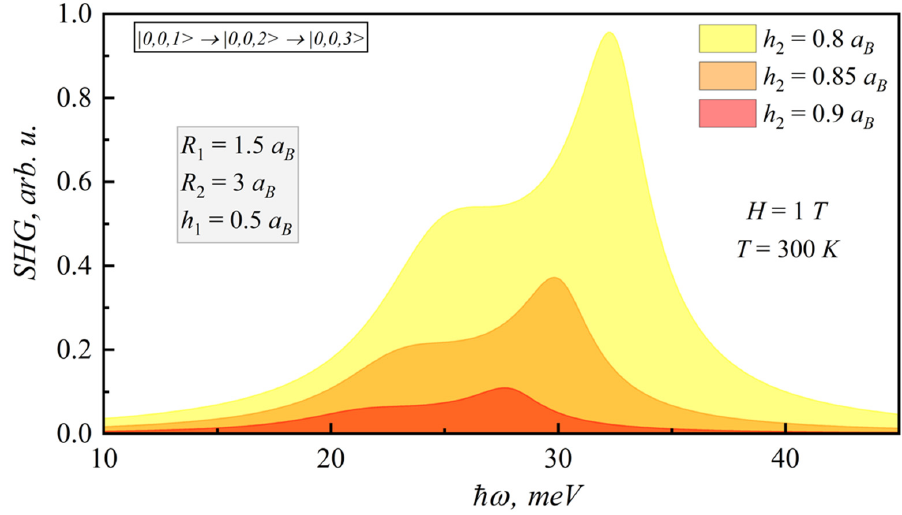
Figure 10. Dependence of SHG coefficient on photonenergy for different lens-shaped QD heights.